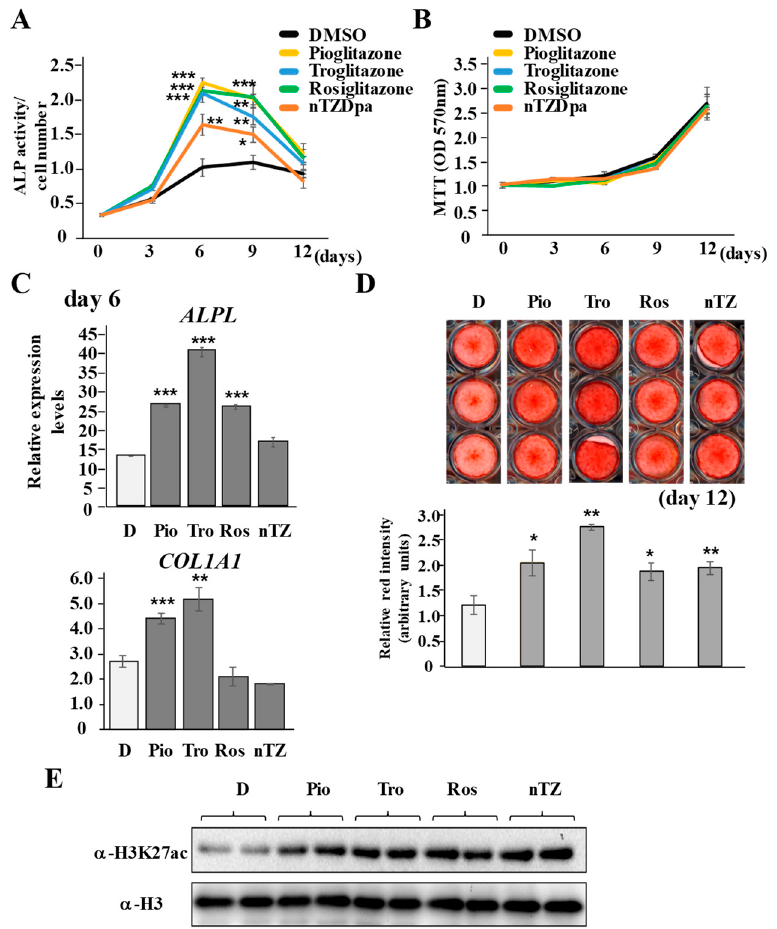
Figure 2. PPAR γ agonists enhance osteo/cementogenic abilities of PDLF-1. ( A – D ) PDLF-1 were cultured in induction medium for a maximum of 15 days. ALP activities were normalized by cell numbers ( A ), cell numbers were enumerated by MTT ( B ), gene expression changes in ALPL and COL1A1 by qPCR ( C ), and calcium deposition were visualized and quantified by Alizarin red S staining ( D ). ( E ) PDLF-1 were cultured in the presence of PPAR γ agonists for 48 h and the global acetylation of H3K27 was analyzed by SDS-PAGE using whole histone H3 as the loading control. H3 = histone 3. * p < 0.05; ** p < 0.01; *** p < 0.001 significantly higher than in cells treated with DMSO on the same day. D = DMSO, Pio = Pioglitazone, Tro = Troglitazone, Ros = Rosiglitazone, nTZ =